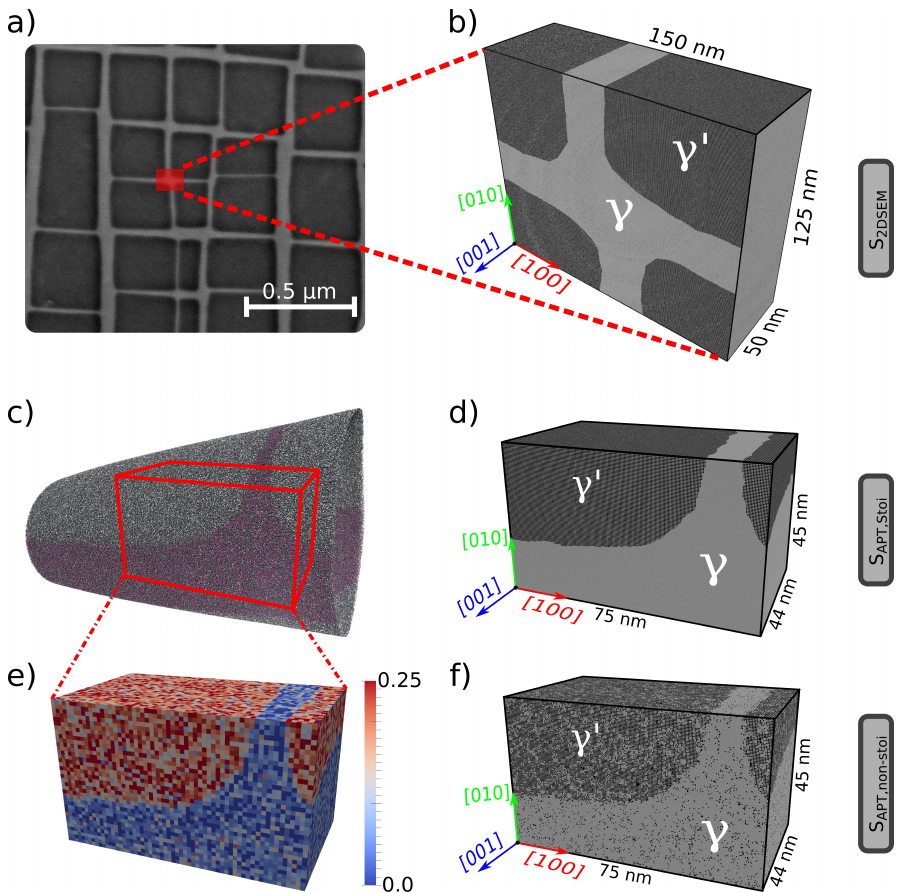
Figure 2. Simulation setup of the realistic samples used in the current work. ( a ) SEM-micrograph of a Ni-base superalloy Astra1 with the γ / γ (cid:48) microstructure [31]. The atomistic sample corresponds to the region of interest marked in red; ( b ) SEM micrograph-informed quasi-2D atomistic sample with dimensions identical to sample S2p in Figure 1d. The channel thickness is 25 nm, and PBCs are imposed only along the thickness of the sample; ( c ) Atom probe tomography (APT) dataset with only Re (magenta), Ni (grey) and Al (black) atoms shown. Only the cuboidal region marked in red is used for further sample generation; ( d ) APT-informed stoichiometric atomistic sample; ( e ) Local concentration of Al in the region of interest in the APT sample; ( f ) APT-informed non-stoichiometric atomistic sample using the local concentrations of Al and Ni in the original APT data. Color code (for the atomistic simulation samples): Ni atoms are colored grey, whilst the Al atoms are colored